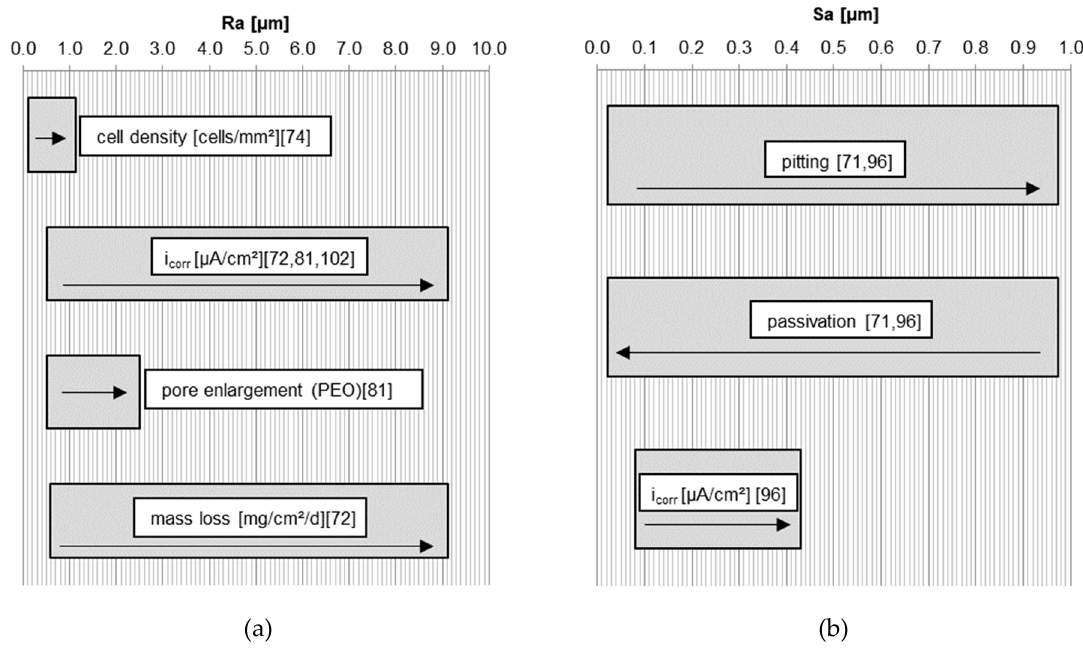
Figure 3. Trend of properties: (a) in relation to roughness Ra. The arrow shows the change of properties depending on the roughness according to [72,74,81,102]; (b) in relation to roughness Sa. The arrow shows the change of properties depending on the roughness according to [71,96].